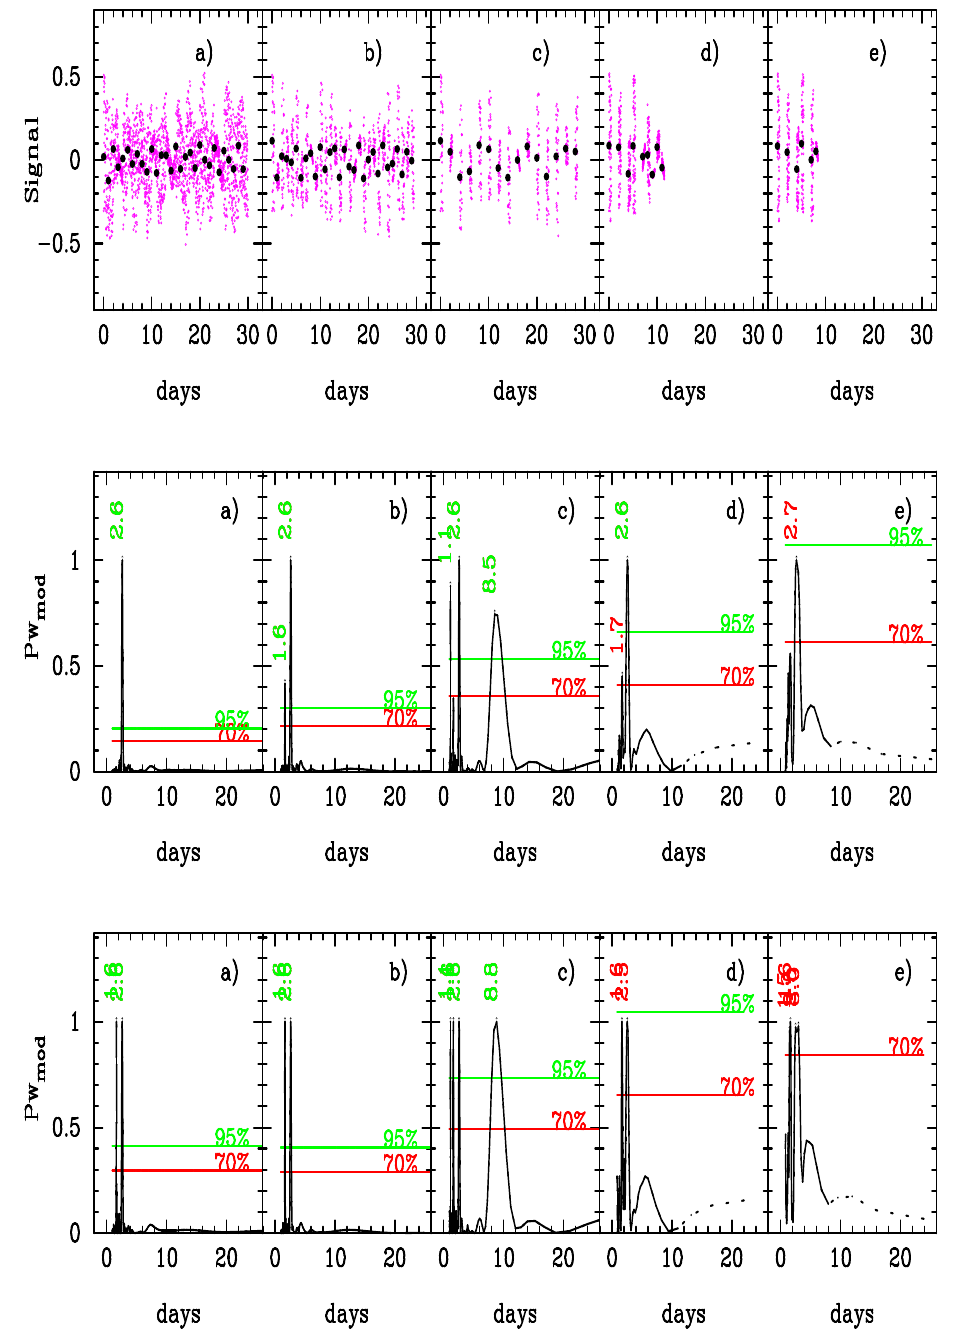
Fig. A1. Upper panel: Numerical simulations of a periodic signal of period 2.6 days plus noise. Points: simulated data at a sampling rate of 3 data per hour. Solid circle: Averaged nightly data. Simulations of 30 days length: (a) No gaps (b) 1 day gaps. (c) 2 day gaps. (d) Simulations of 15 day length with gaps of 1 day and irregular 2 day gaps (e) as (d) but a simulation of 9 days. Middle panel: Periodograms of all the data time series. Lower panel: Periodograms of nightly averaged data time